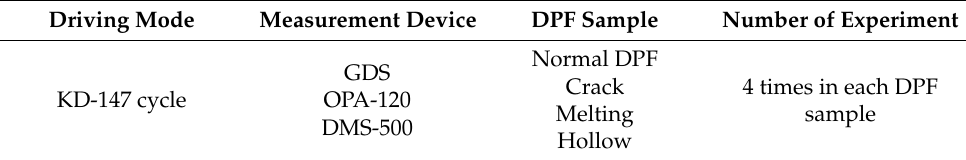
Table 5. Experimental condition.